Question: Write a single sentence explaining what this figure depicts.
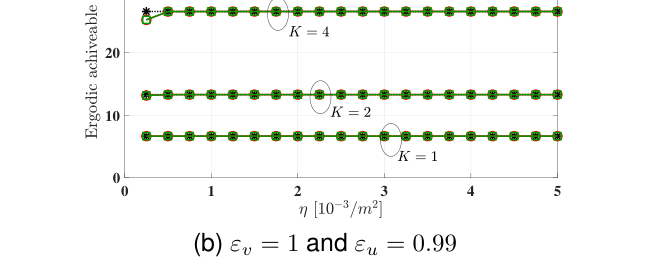
Answer: Theoretical analysis (31), (32) and simulation results of the achievable sum-rate R versus the deployed BS density η for different number of UEs K, with ρ = 20dB.